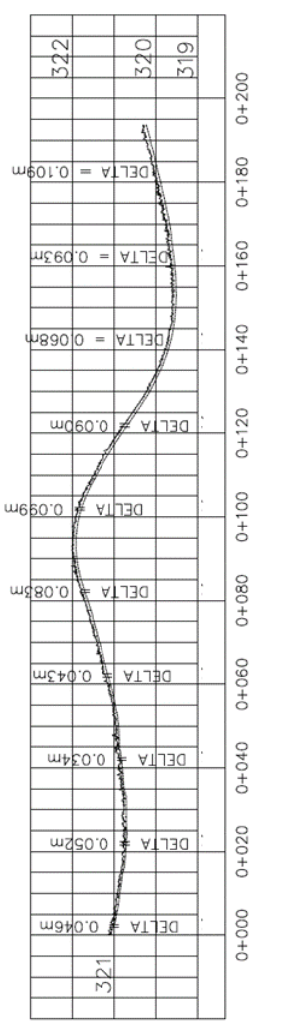
Figure 9. Elevation differences computed at stations along the road centreline (all values in